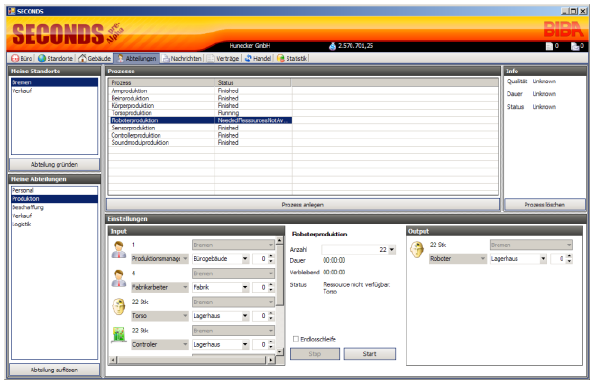
Figure 5: GUI shows the input needed for producing robots